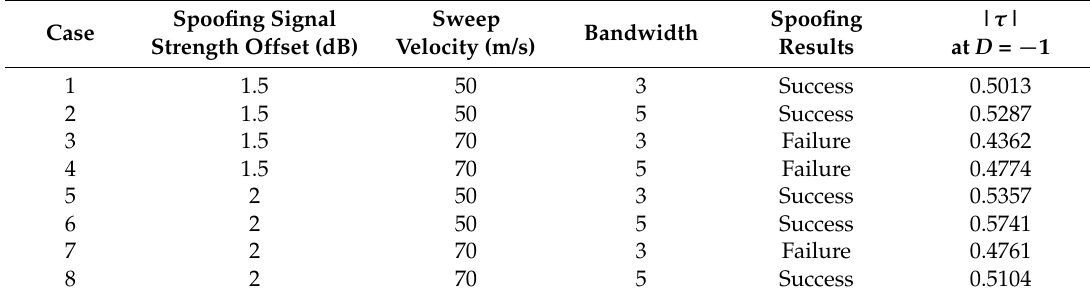
Table 3. Integration time calculation according to CI.